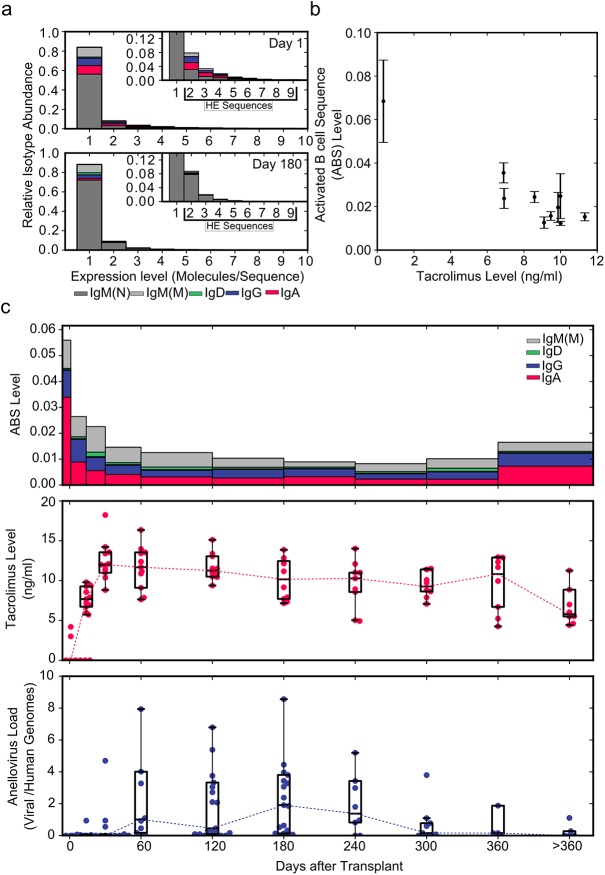
Using immune repertoire sequencing to measure immunosuppression.(A) Relative IGH sequence composition at increasing expression levels (molecules/sequence) is shown across all individuals (n = 12) in a histogram for days 1 and 180 post-transplant. Bar colors indicate the contribution of different immunoglobulin isotypes. Inserts show rescaled histograms. Highly expressed (HE) sequences (sequences represented by more than one molecule) are labeled in the insert. (B) ABS level (defined as the ratio of all highly expressed IgA, IgD, IgE, IgG, and mutated IgM sequences to the total number of molecules) as a function of tacrolimus trough level (n = 130) (average ± standard error of the mean). (C) Median ABS level (colors indicate isotype contribution), tacrolimus trough level, and total anellovirus load for all study patients (n = 12) during the first year after transplant.